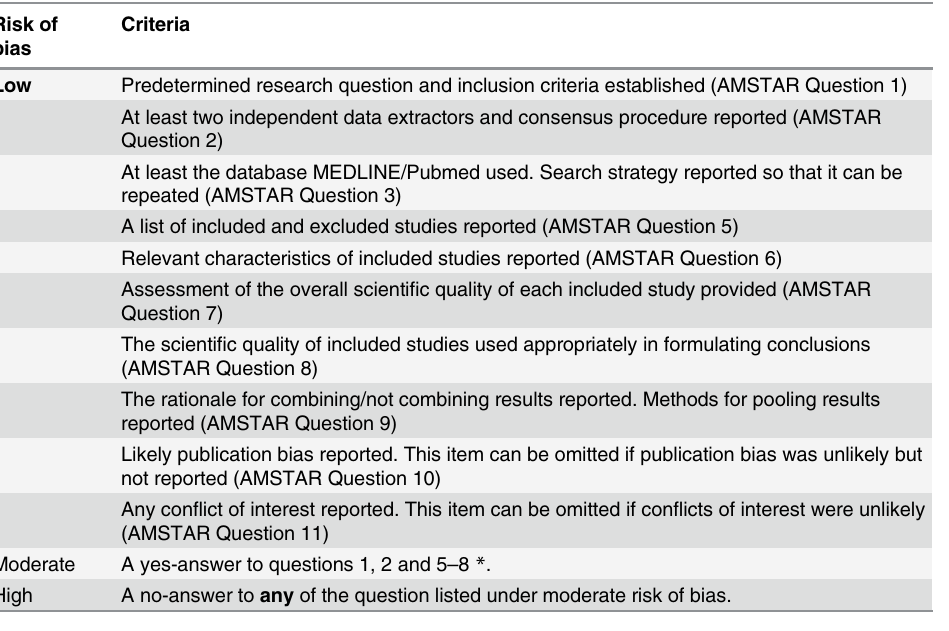
Table 1. Criteria for assessing risk of